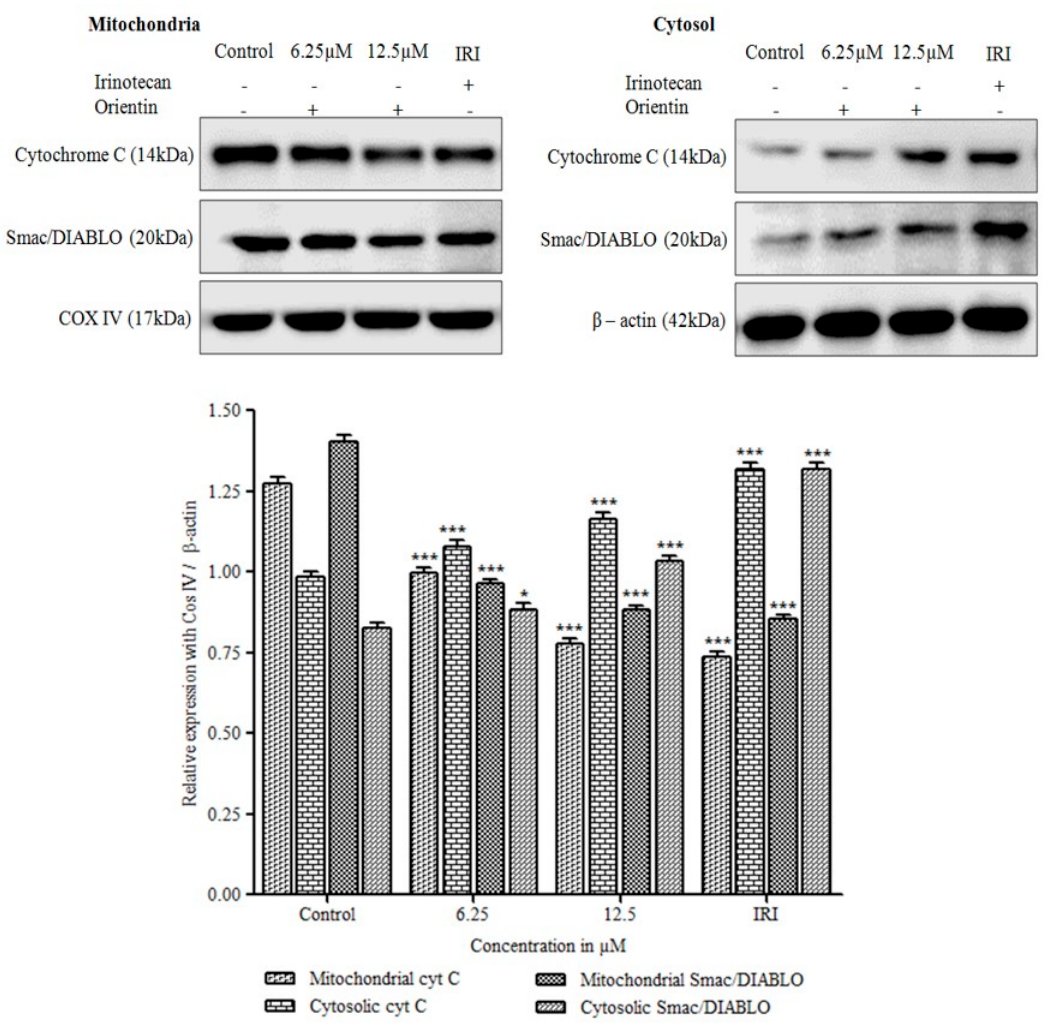
Figure 9. Effect of orientin on cytochrome C release and Smac/DIABLO protein. Orientin induces the translocation of cytochrome C and Smac/DIABLO from mitochondria to cytosol in HT29 cells. β -actin was used as an internal control. Quantitative expression of proteins has shown after normalization to β -actin. Values are represented as the mean ± SD of three independent experiments (* p < 0.05, ** p < 0.01 and *** p < 0.001 vs. control).